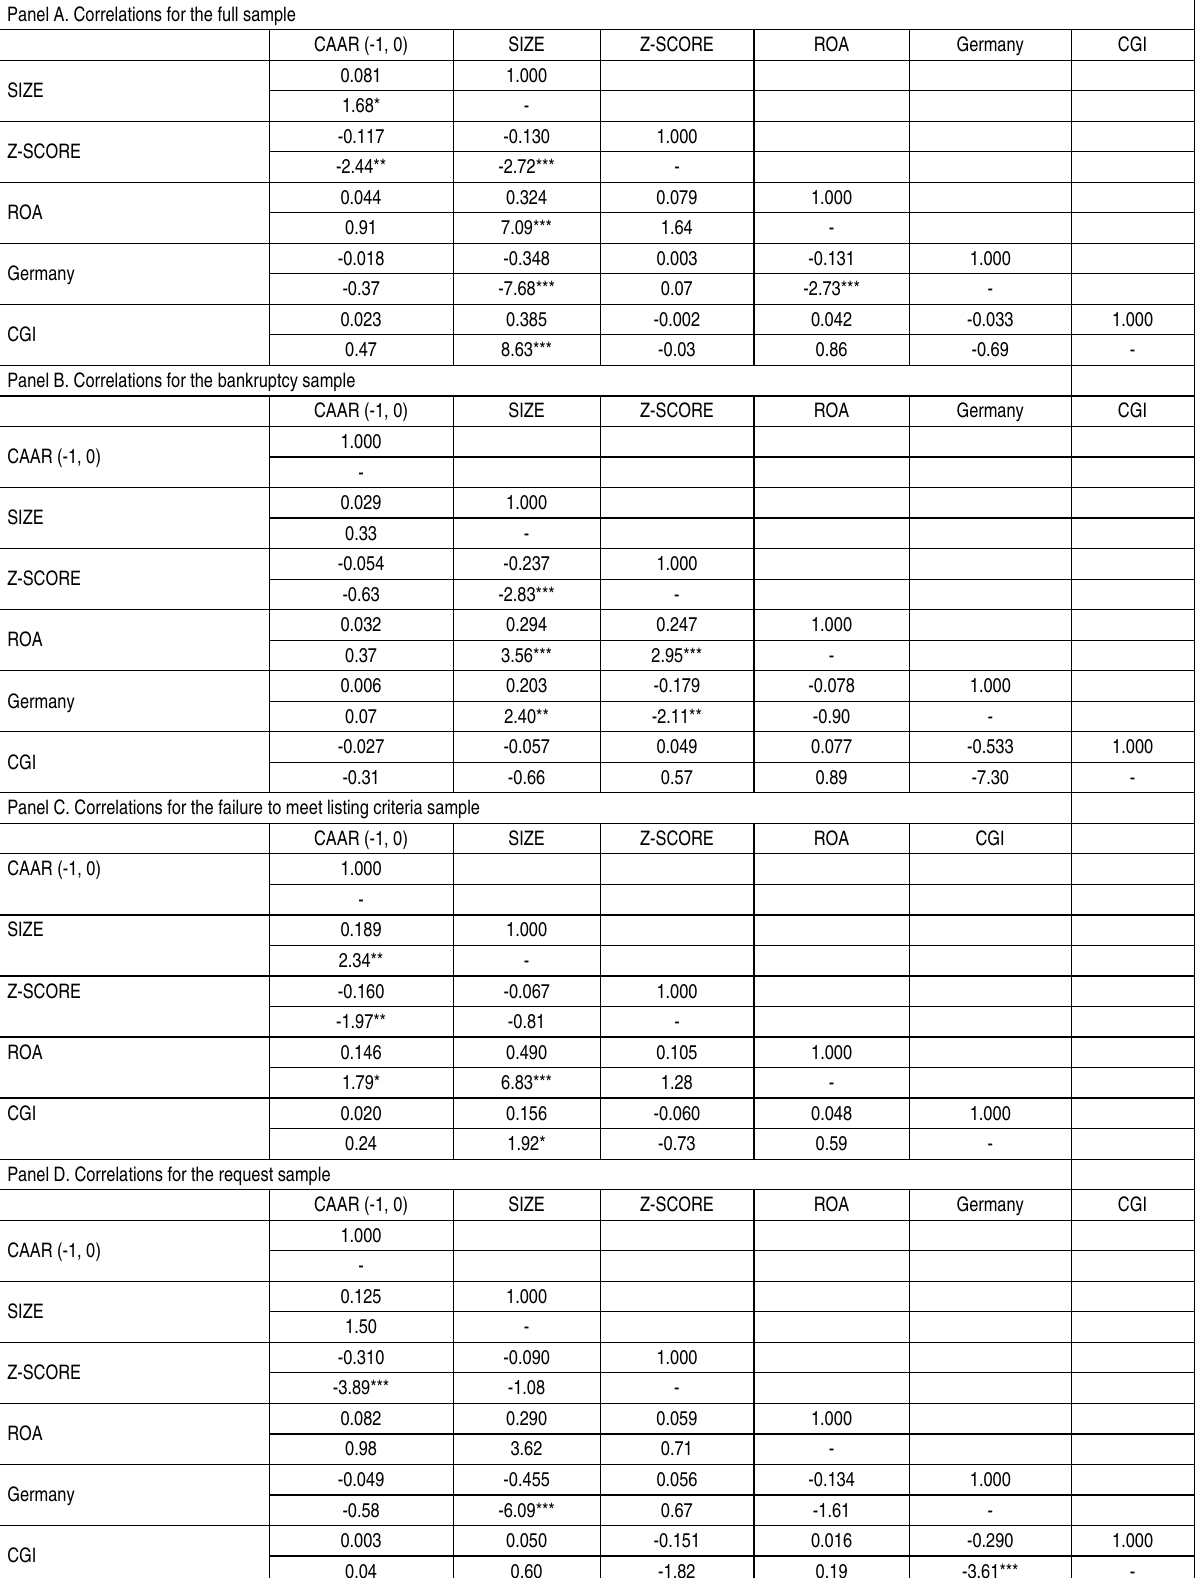
Table 7 (cont.). Correlation between regression estimates variables Panel A. Correlations for the full sample